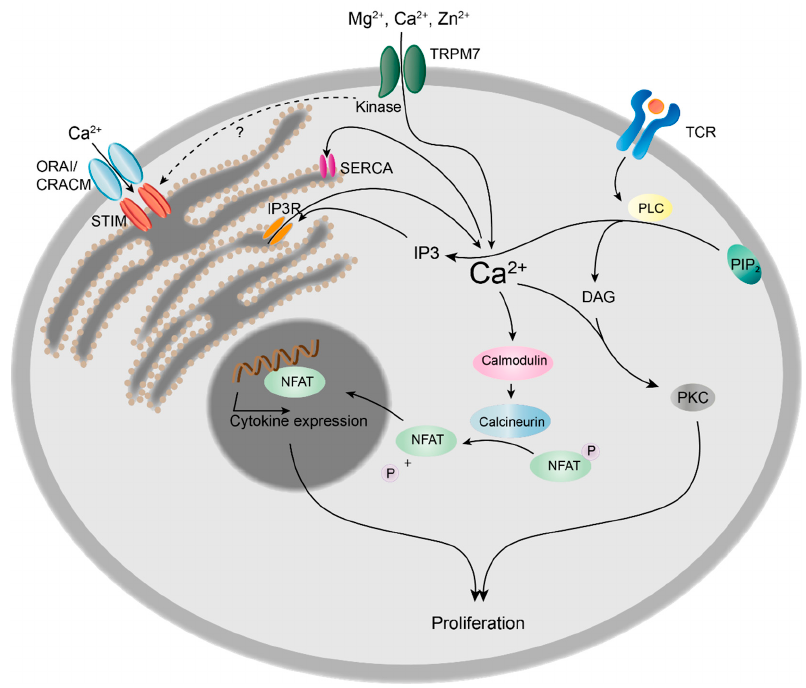
Figure 2. Role of TRPM7 kinase in calcium signalling and proliferation of T cells. Upon T cell receptor (TCR) binding, phospholipase C (PLC) is activated and hydrolyses phosphatidylinositol 4,5-biphosphate (PIP 2 ) to inositol 1,4,5-triphosphate (IP 3 ) and diacylglycerol (DAG). DAG in conjunction with Ca 2+ activates protein kinase C (PKC), thus inducing cell proliferation. IP 3 induces Ca 2+ release from the endoplasmic reticulum (ER) via IP 3 receptor (IP 3 R), followed by the translocation of the stromal interaction molecule (STIM) to the plasma membrane. STIM triggers Ca 2+ influx from the extracellular space via ORAI/CRACM channels. Ca 2+ is rapidly removed from the cytosol by the sarco/endoplasmic reticulum Ca 2+ -ATPase (SERCA), refilling the ER Ca 2+ stores. The prolonged increase in cytosolic Ca 2+ concentrations leads to the activation of calcineurin, resulting in the dephosphorylation and nuclear translocation of nuclear factor of activated T cells (NFAT) and subsequent cytokine expression, e.g., interleukin 2 (IL-2), triggering clonal expansion of T